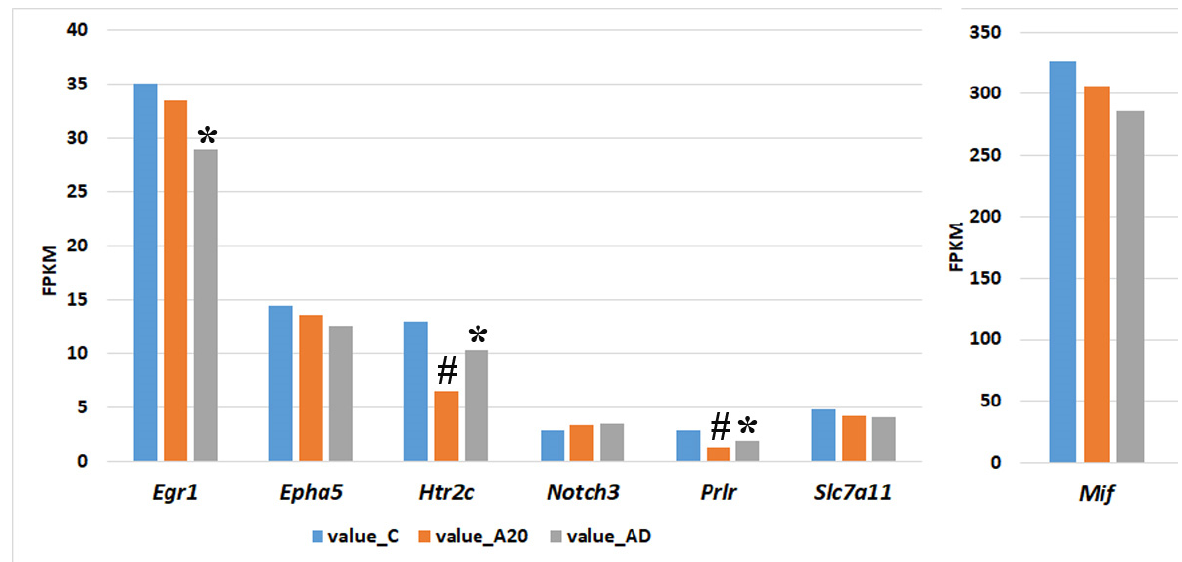
Figure 7. Neurogenesis-associated C_AD DEGs whose expression changed during the fighting deprivation. * DEGs in the A20_AD comparison; # DEGs in the C_A20 comparison. FPKM, fragments per kilobase of transcript per million mapped reads; value C: expression in control mice (no experience of agonistic interactions); value_A20: expression in males with consecutive 20 days of wins in daily agonistic interactions; value_AD: expression in males with consecutive 20 days of wins in daily agonistic interactions and then deprived of fighting for 14 days.